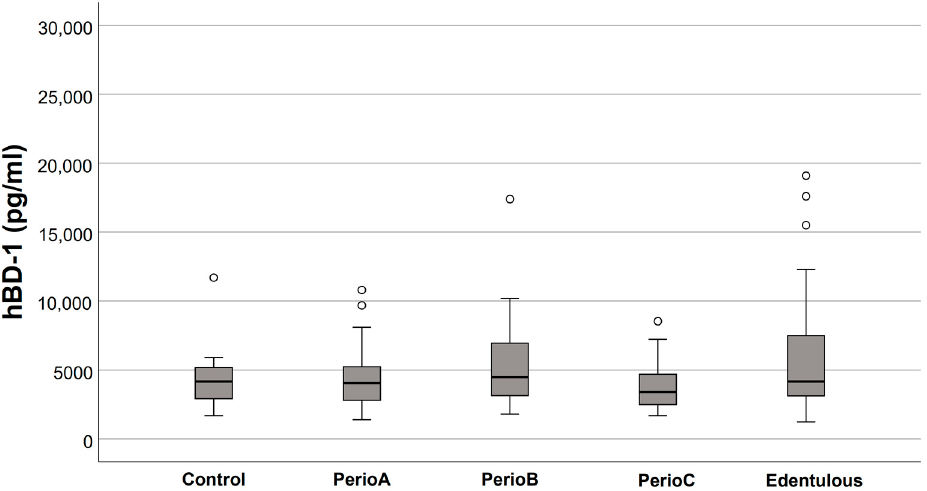
Figure 2. Salivary human β -defensin (hBD)-1 levels in relation to the extent of periodontal destruction (empty circles indicate outliers). No significant differences were found between the groups.